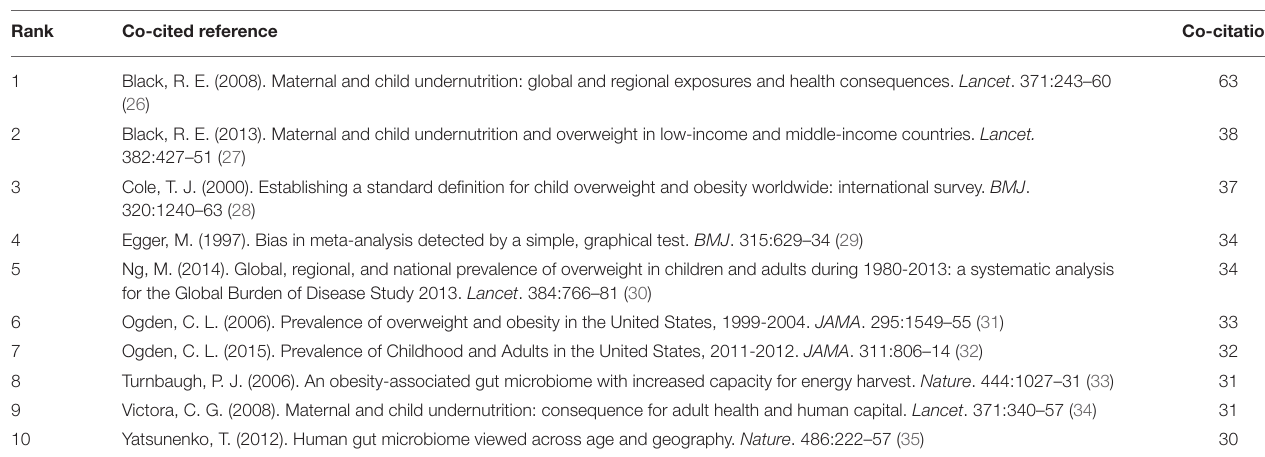
TABLE 4 | Top 10 co-cited